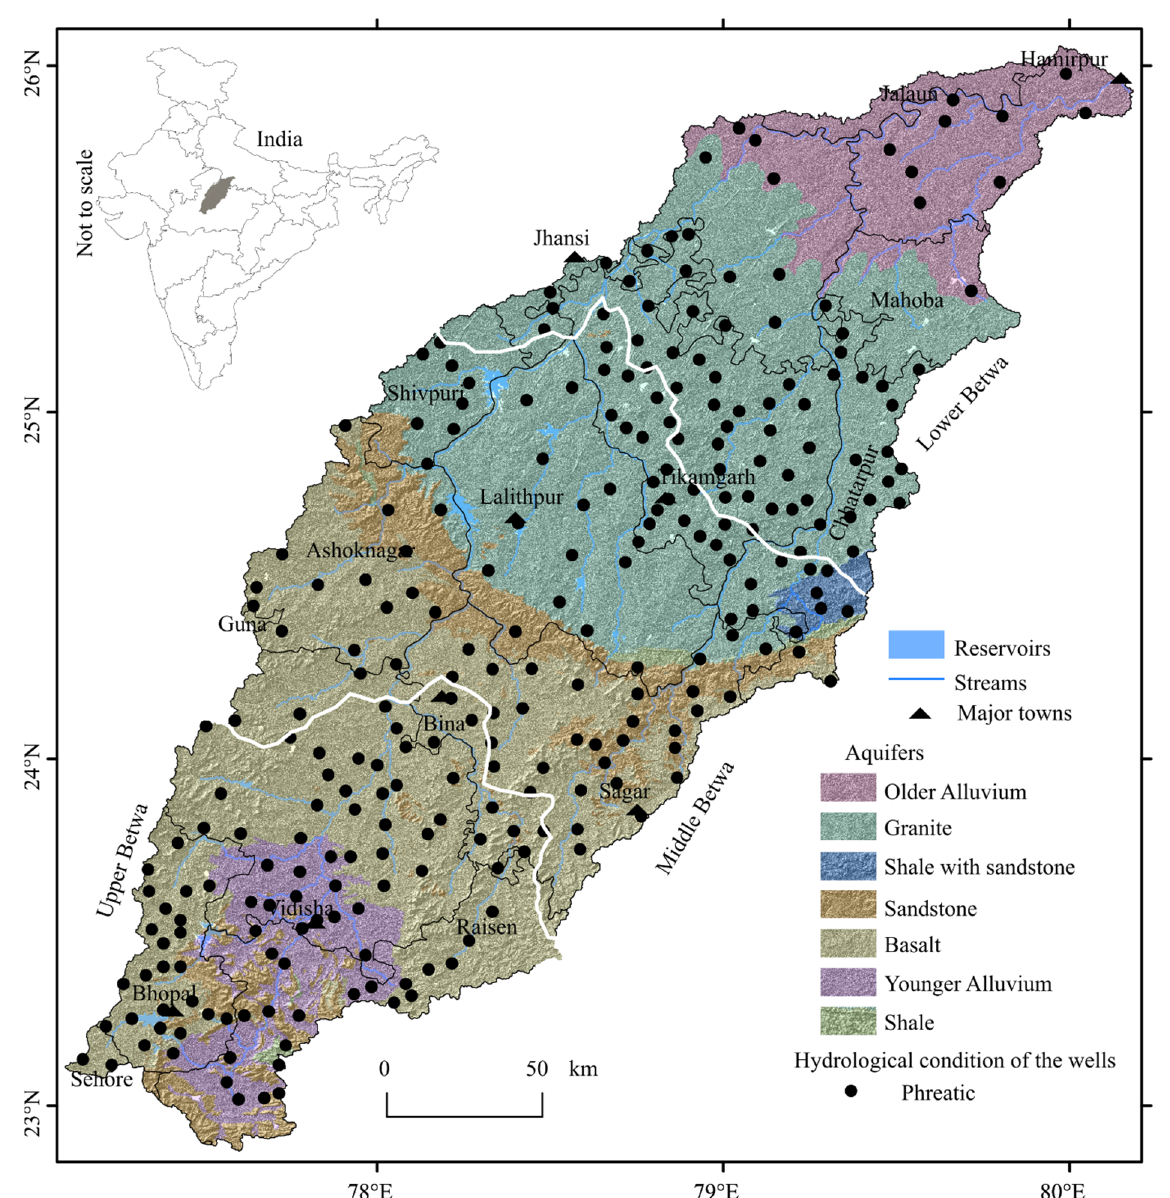
Figure 1. Lithology map of the Betwa River basin is superimposed on a topographic map. Polygons in solid black is to show the district administrative boundary. Points in black represent the location of wells where the GWL data is monitored. The solid line in blue represents the drainage network.